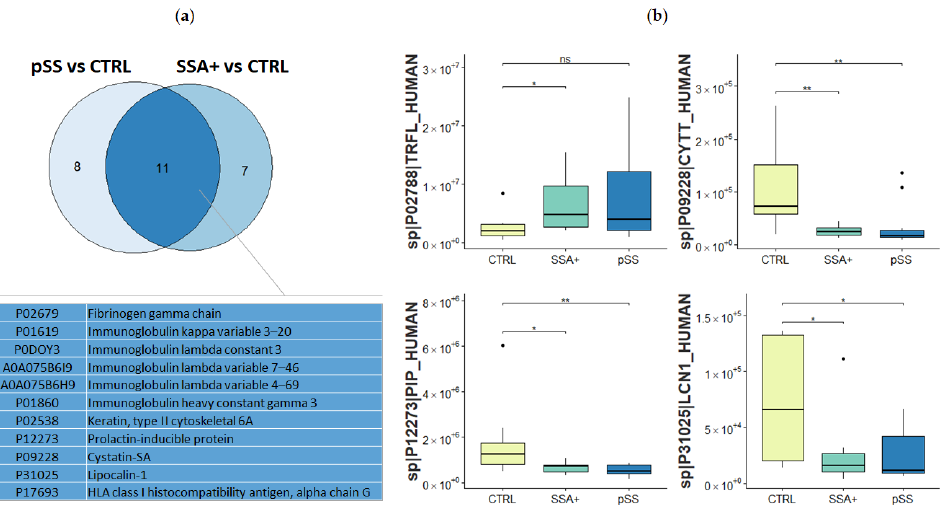
Figure 3. ( a ) Venn diagram of significantly dysregulated proteins (with a FC higher than 1.5 or lower than 1/1.5 and with statistical significance set at p < 0.05) in pSS and SSA+ patients, compared to controls. In total, 19 proteins were significantly dysregulated in pSS patients, while 18 proteins were significantly dysregulated in SSA+ patients, and 11 of these proteins are in common. ( b ) Box plot reporting protein abundances for proteins of biological interest in Sjögren’s syndrome. Protein abundance distributions are calculated for the three groups of subjects—healthy controls, SSA+, and pSS patients—and a two-tailed Mann Whitney U-test was performed to consider the significant differences in protein levels between patients and controls (statistically significant p -values are shown as follows: * p -value < 0.05, ** p -value <